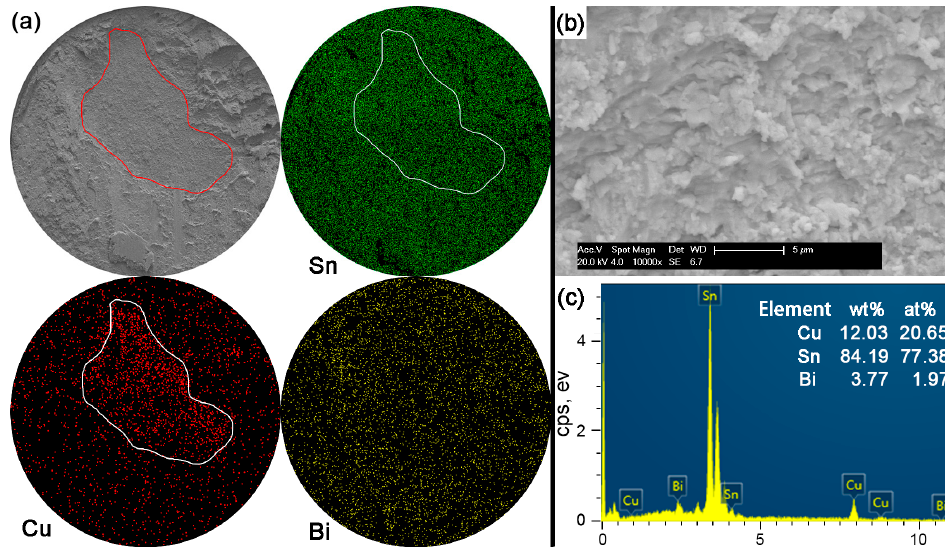
Figure 11. Fracture morphologies of as-soldered Sn-5Bi solder bump: ( a ) SEM image and elemental mapping; ( b ) interfacial fracture at higher magnification; and ( c ) EDS analysis on image ( b ).